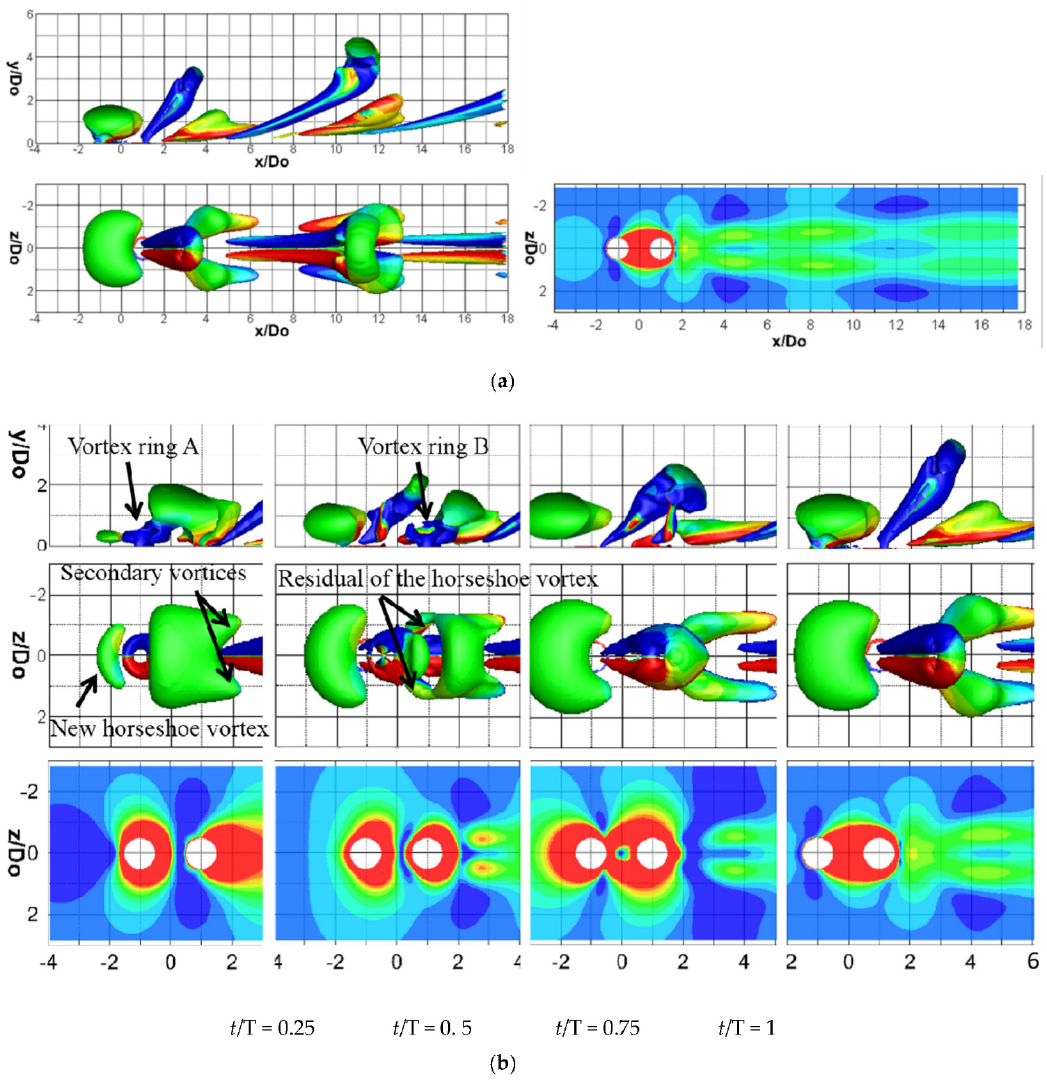
Figure 12. Vortex structures and excess wall shear stress for the twin SJs operating with Δ ϕ = π /2. ( a ) Vortex structures ( left ) and excess wall shear stress ( right ) at t /T = 0. ( b ) Evolution of vortices ( upper two rows) and corresponding excess wall shear stress ( bottom row). The color map can be referred to Figure 11.